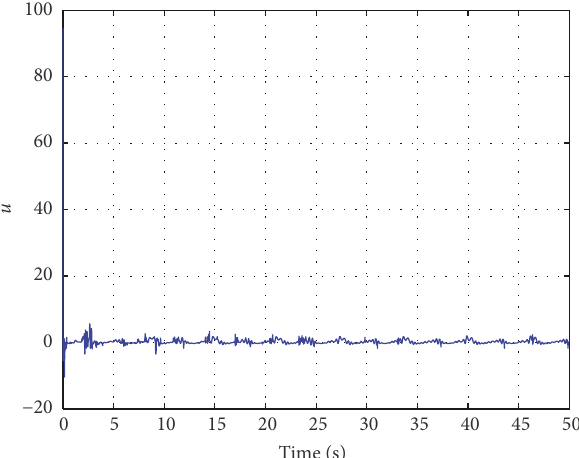
Figure 3: Trajectory of control input signal 𝑢(𝑡) .